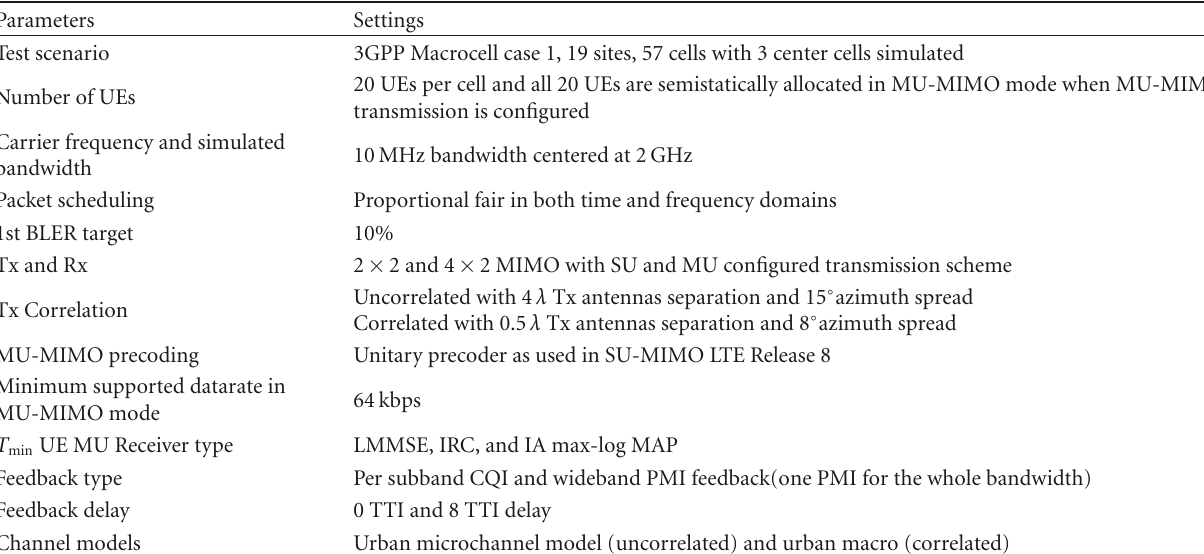
Table 3: Basic LTE Parameters Used in the